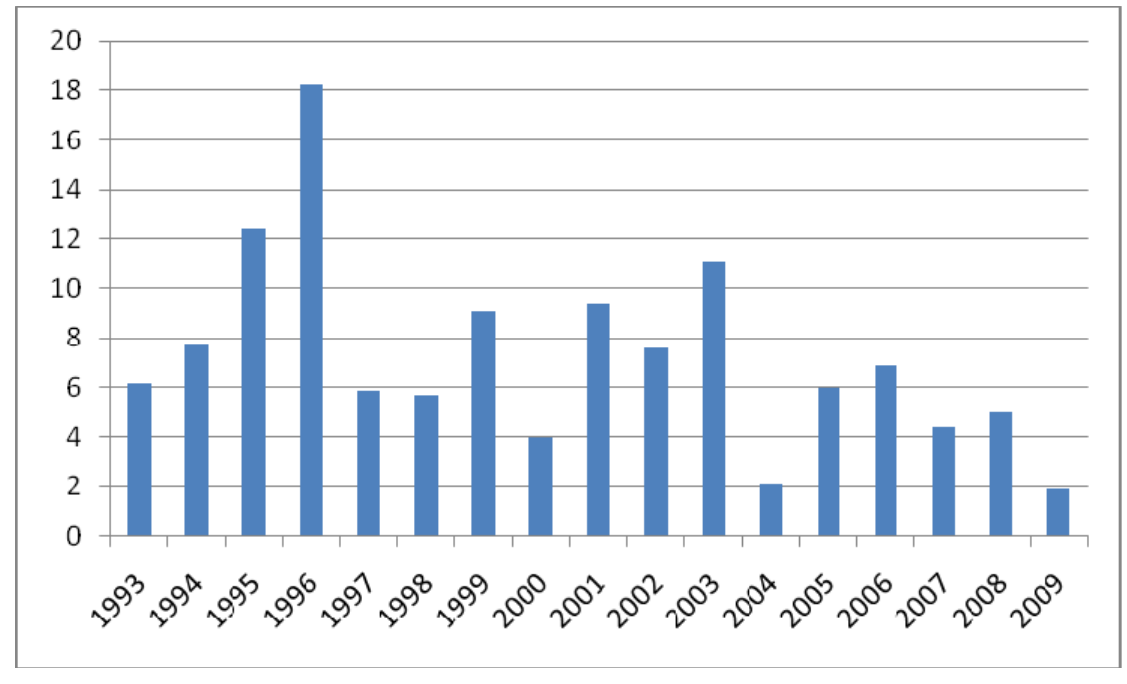
Figure 5. Total December colony area (in hectares) for Monarch butterflies overwintering in Mexico from 1993 to 2009 (modified from Rendón-Salinas et al .,